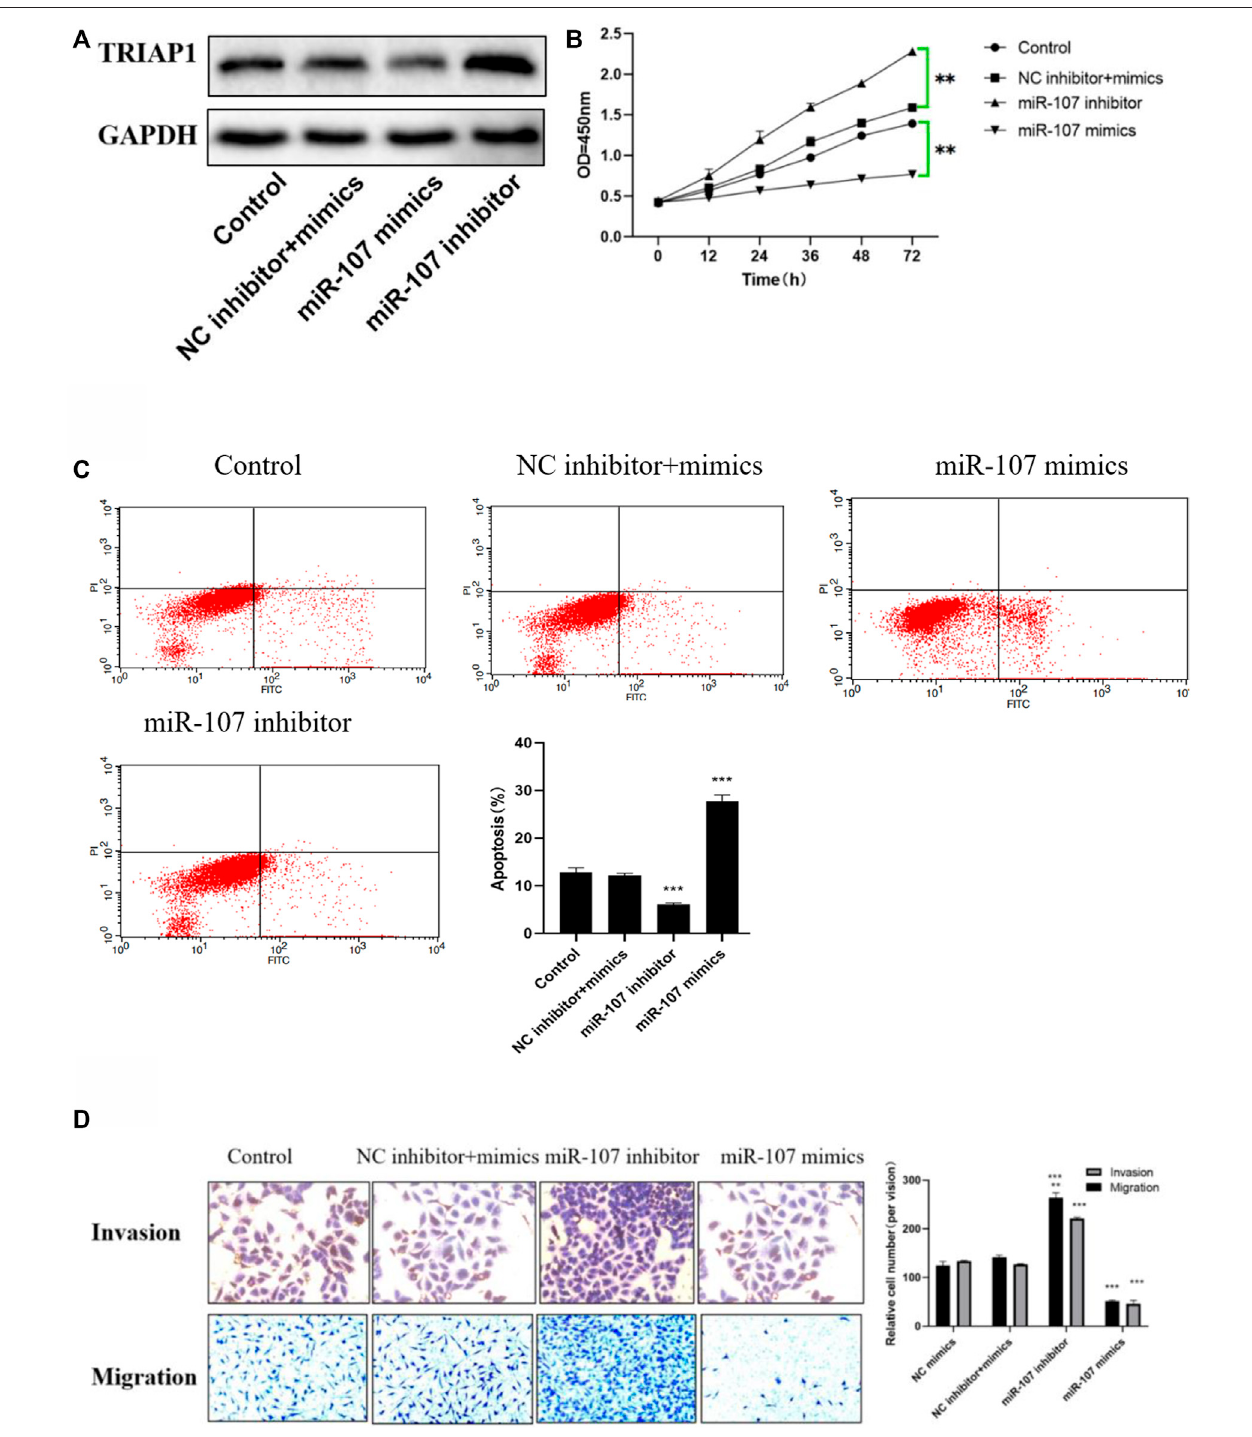
FIGURE4| miR-107inhibitsmetastasisandproliferationofNCI-N87cells invitro (A) ProteinexpressionofTRIAP1aftermiR-107knock-down/overexpression, (B) Proliferation analysis of NCI-N87 cells after miR-107 knock-down/overexpression; (C) Apoptosis analysis of NCI-N87 cells after miR-107 knock-down/overexpression; (D) Invasion and migration of NCI-N87 cells after miR-107 knock-down/overexpression (original picture X100), Compared with the control group,* p < 0.05,** p < 0.01,*** p < 0.001.